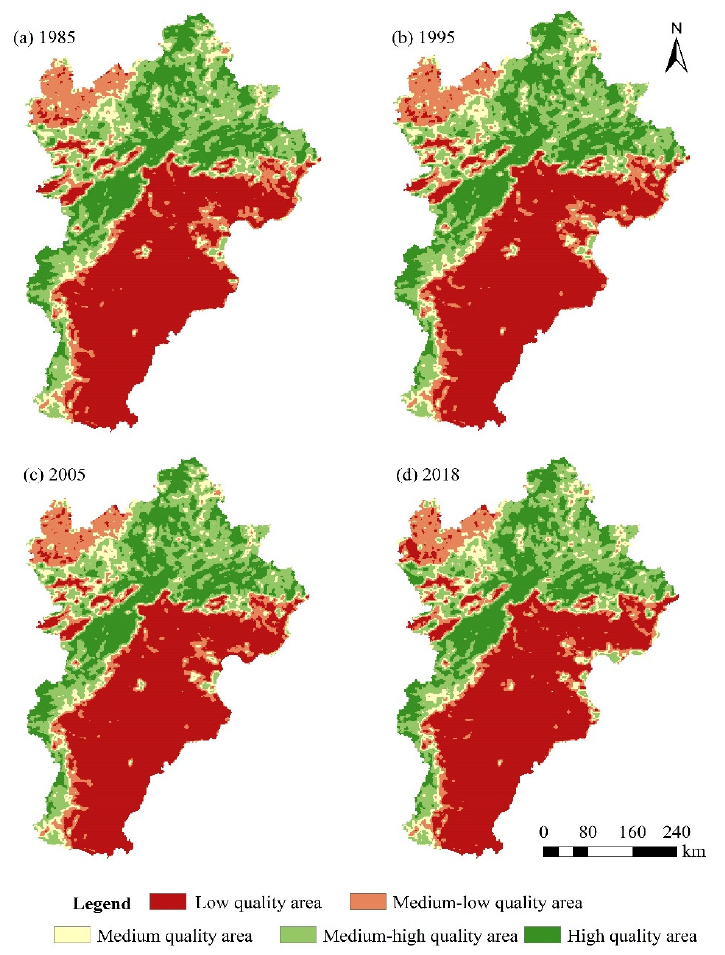
Figure 5. Distribution of ecological environment quality in the BTH region.